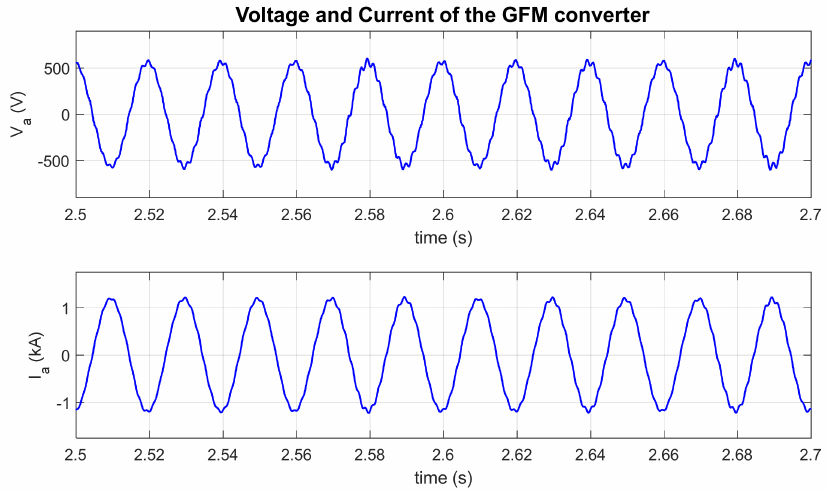
Figure 23. Inverter voltage and current of phase a of the converter in steady